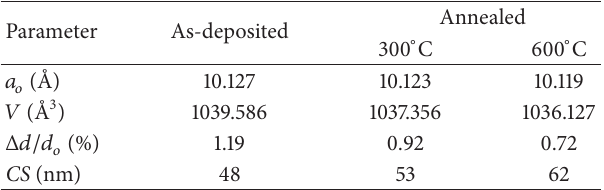
Table 1: Structural parameters of as-deposited and annealed ITO thin